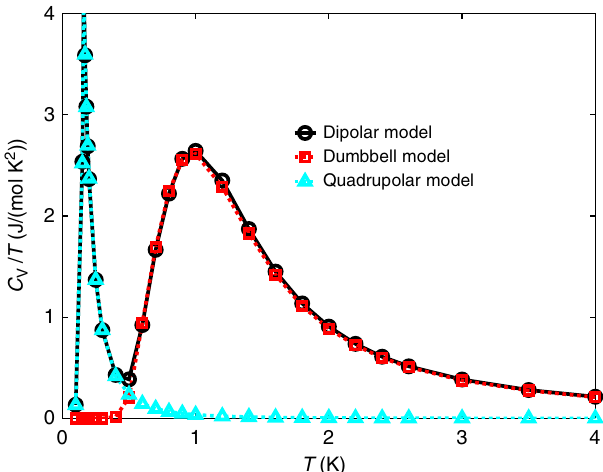
Fig. 4 Dumbbell – quadrupolar decomposition of the spin ice susceptibility. Susceptibility χ T / C for the g + – DSM (black) along with the dumbbell (red) and quadrupolar (cyan) contributions. The product of the dumbbell and quadrupolar susceptibility is shown in blue